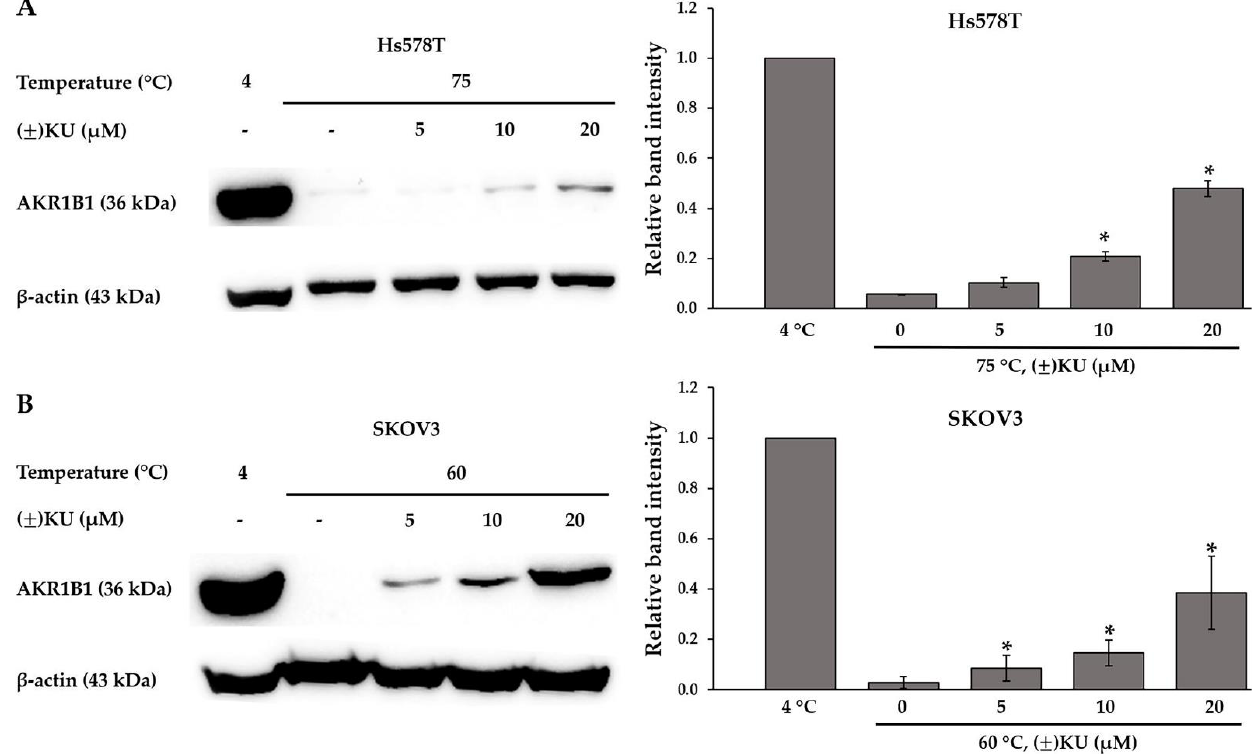
Figure 4 . CETSA - based determination of target engagement between ( ± ) KU and AKR1B1 . ( A ) Figure 4. CETSA-based determination of target engagement between ( ± )KU and AKR1B1. ( A ) Hs578T Hs578T and ( B ) SKOV3 cells were treated with various concentrations of ( ± ) KU ( 5, 10 and 20 μ M ) and ( B ) SKOV3 cells were treated with various concentrations of ( ± )KU (5, 10 and 20 µ M) at 37 ◦ C for at 37 °C for 1 h . Then, cells were harvested and heated at 75 and 60 °C, respectively, followed by 1 h. Then, cells were harvested and heated at 75 and 60 ◦ C, respectively, followed by determination determination using Western blot analysis . The quantitative protein level of AKR1B1 was normal- using Western blot analysis. The quantitative protein level of AKR1B1 was normalized with β -actin ized with β- actin band intensity . Data are represented as mean ± SD with three independent exper- iments . Statistically significant differences between treated cells and non-treated cells were deter- band intensity. Data are represented as mean ± SD with three independent experiments. Statistically mined by the student ’ s t - test (* p < 0 . 05 ). ( ± ) KU, trans -( ± )- kusunokinin . significant differences between treated cells and non-treated cells were determined by the student’s t -test (* p < 0.05). ( ± )KU, trans -( ± 3 . 5 . ( ± ) KU Inhibited Lipid Peroxidation in High-Glucose Condition In order to evaluate the inhibitory effect of ( ± ) KU on high-glucose - induced AKR1B1 - mediated oxidative stress response, Hs578T cell lines detected lipid peroxidation using TBARS assay . Hs578T cells were selected to perform in consequence of the more potential cytotoxic effect than SKOV3 cells . Hs578T cells were incubated with ( ± ) KU and EP at 0 . 25×, 0 . 50× and 1 . 00× IC 50 ( 1 . 40, 2 . 79, 5 .58 μ M for ( ± ) KU and 24 . 02, 48 . 04, 96 .08 μ M for EP, respectively ) for 24 h . Then, oxidative stress was induced with a high glucose concentra- tion at 100 mM for 1 h . After that, cells were measured for the quantitation of malondial- dehyde ( MDA ) , which form as MDA – TBA adduction . The results revealed cells that were induced with a high glucose concentration and markedly increased MDA levels compared with those not treated with high glucose . Interestingly, cells that were pretreated with ( ± ) KU and EP showed significantly decreased MDA levels in a dose - dependent manner ( Figure 5A ). However, ( ± ) KU showed decreased MDA levels, which were lower than EP when compared to the concentration of IC 50 values of cytotoxicity on Hs578T cells, which provide different concentrations . We also further detected the MDA levels when we pre- treated the cells with ( ± ) KU and EP at the same concentration ( 1 . 5, 6 . 0 and 3 .0 μ M ). We found that ( ± ) KU showed significantly decreased MDA levels, which were better than EP ( Figure 5B ).